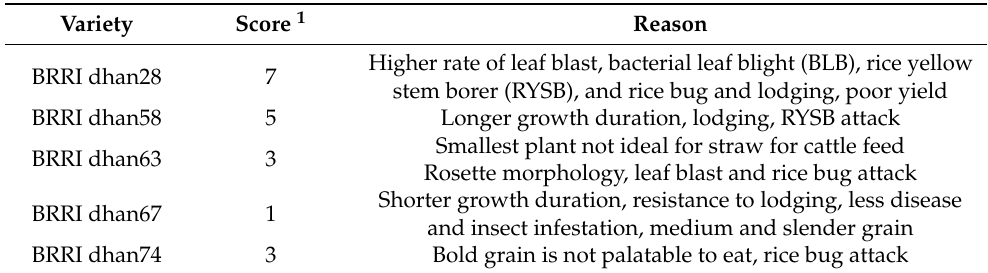
Table 7. Farmers’ preference scores for different rice varieties. Variety Score 1 Reason Higher rate of leaf blast, bacterial leaf blight (BLB), rice yellow BRRI dhan28 stem borer (RYSB), and rice bug and lodging, poor yield BRRI dhan58 Longer growth duration, lodging, RYSB attack Smallest plant not ideal for straw for cattle feed Rosette morphology, leaf blast and rice bug